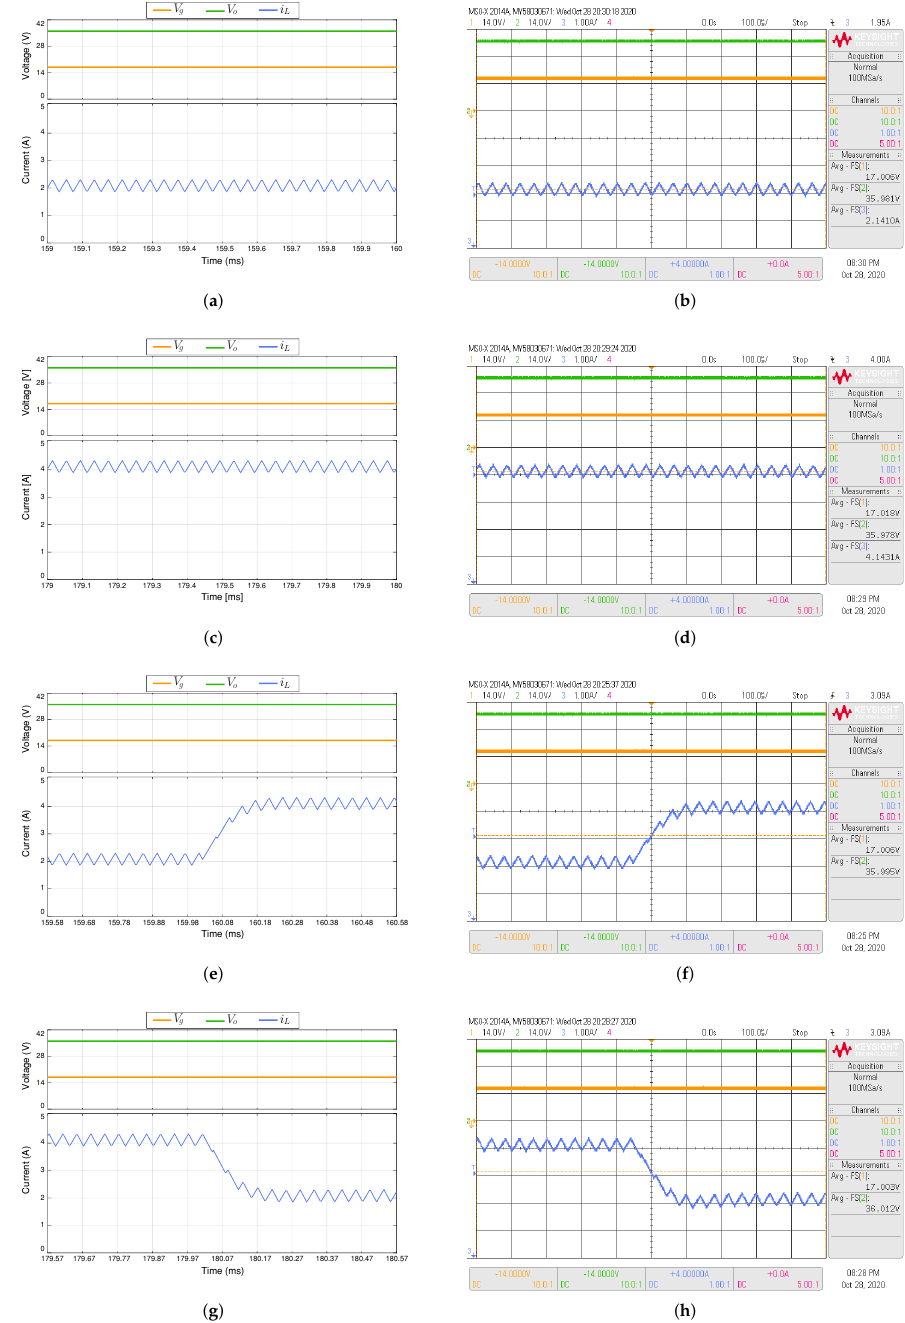
Figure 6. Simulated ( a , c , e , g ) and experimental ( b , d , f , h ) responses of the input current control based on the discrete-time sliding-mode current strategy when the reference i ref : ( a , b ) is equal to 2 A, ( c , d ) is equal to 4 A, ( e , f ) changes from 2 A to 4 A, and ( g , h ) from 4 A to 2 A. The converter is operating with an input voltage V g = 17 V and an output voltage V o = 36 V). CH1: V g (14 V/div), CH2: V o (14 V/div), CH3: i L (1 A/div) and a time base of 100 µ